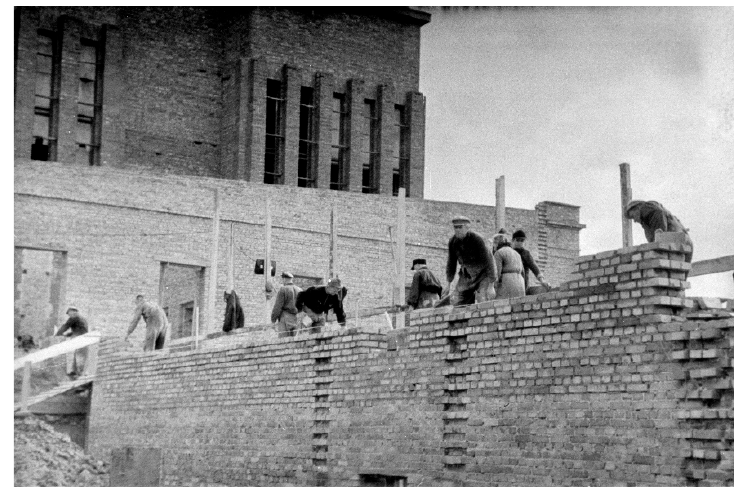
Figure 9. The Kaunas Radio Factory construction, 1953 (source: Lithuanian Central State Archives).